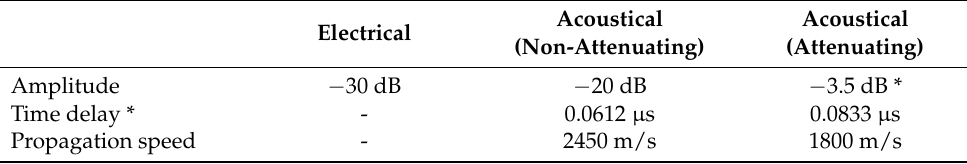
Table A2. Parameters for crosstalk